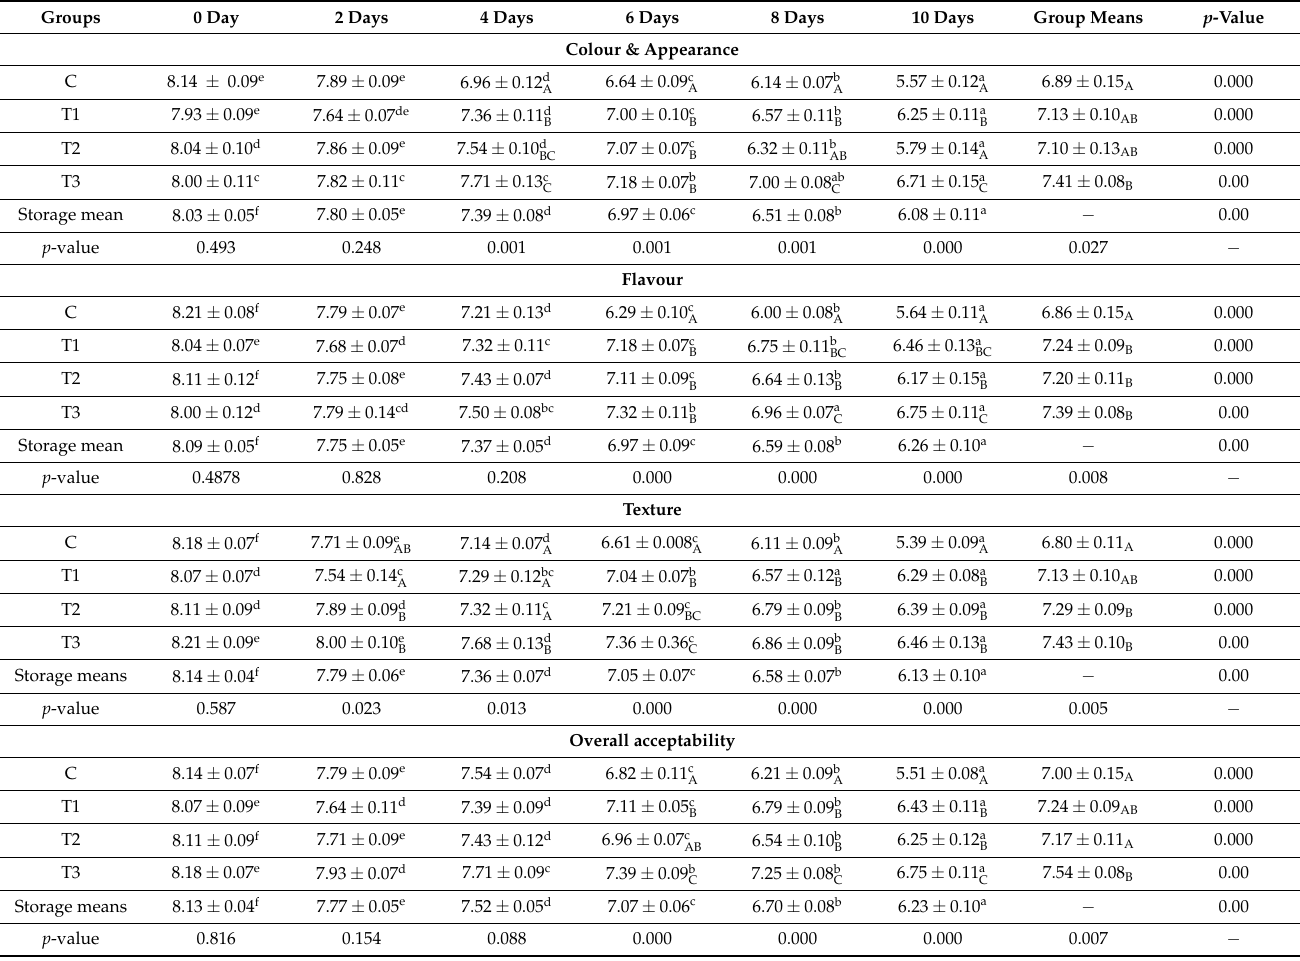
Table 4. Effects of turmeric and aloe vera extracts on sensory attributes of goat and buffalo paneer during refrigerated aerobic